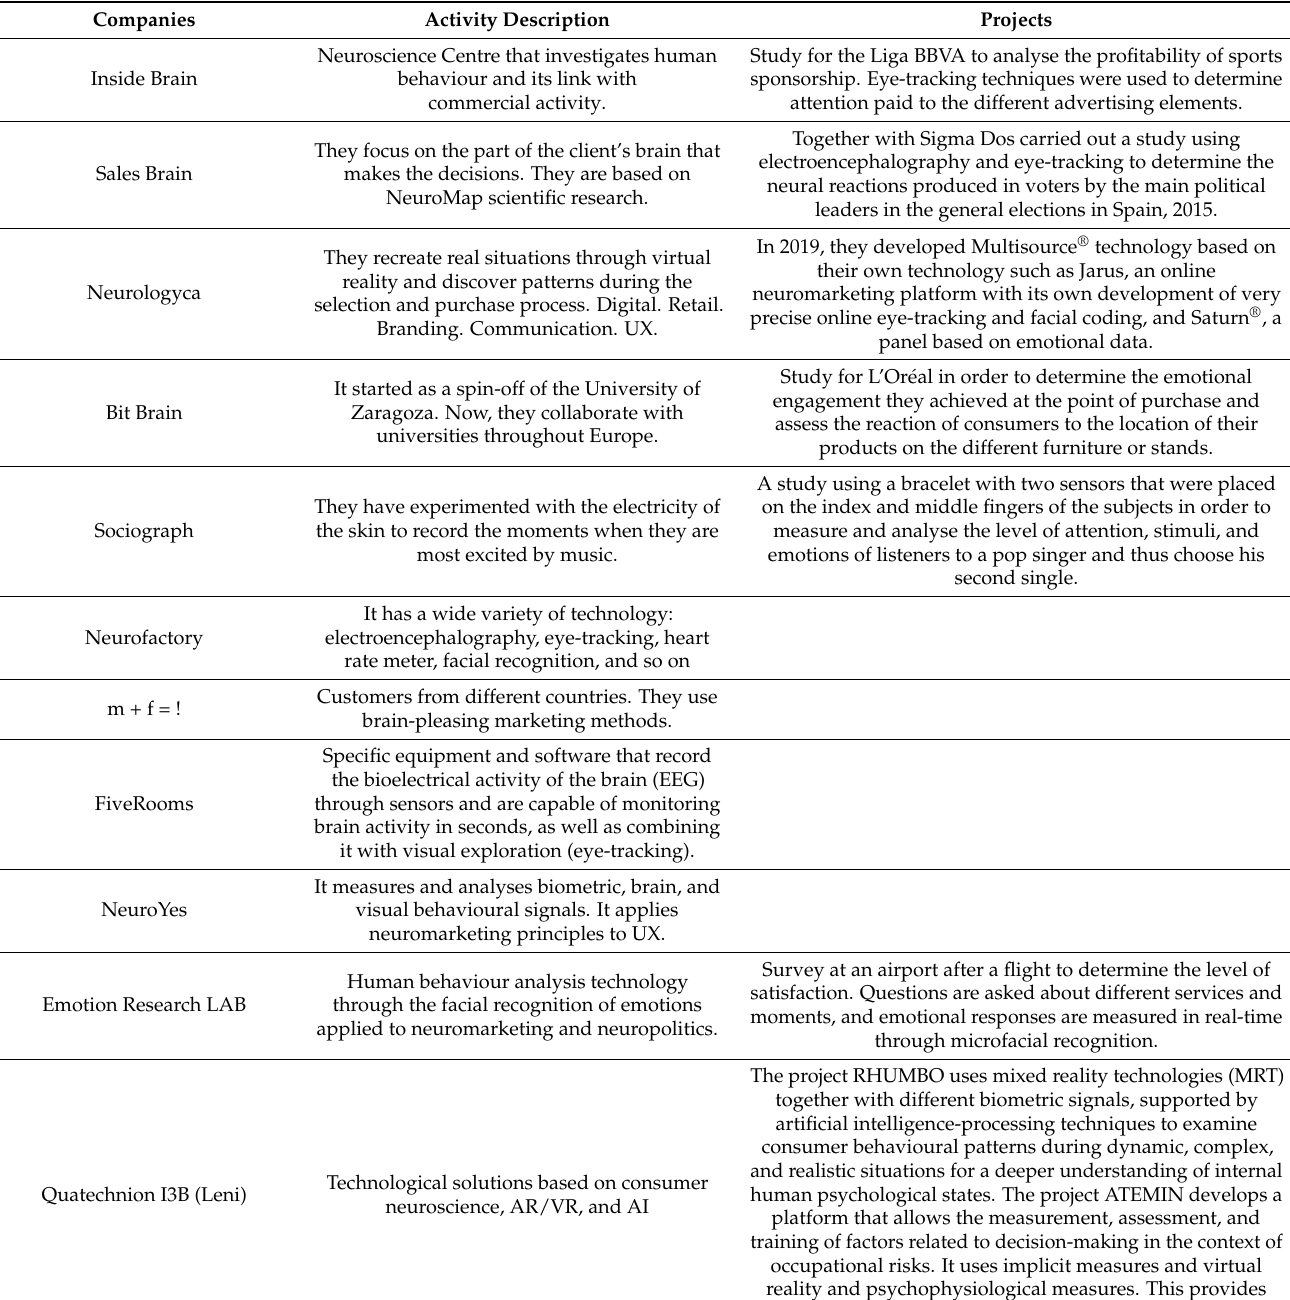
Table 3. Most important neuromarketing companies in